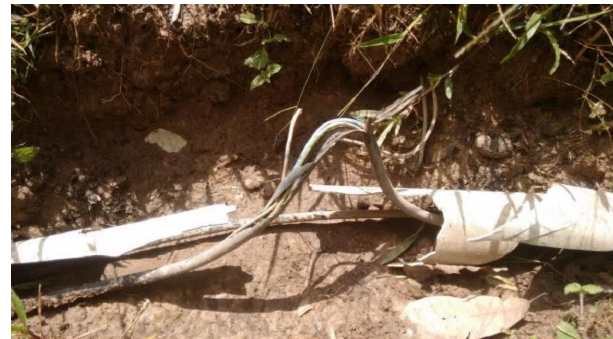
Figure 11. The power cable between the variometer house and the electronics house was damaged a few metres from the variometer house due to currents induced by a lightning strike close to Tatuoca observatory on 31 December